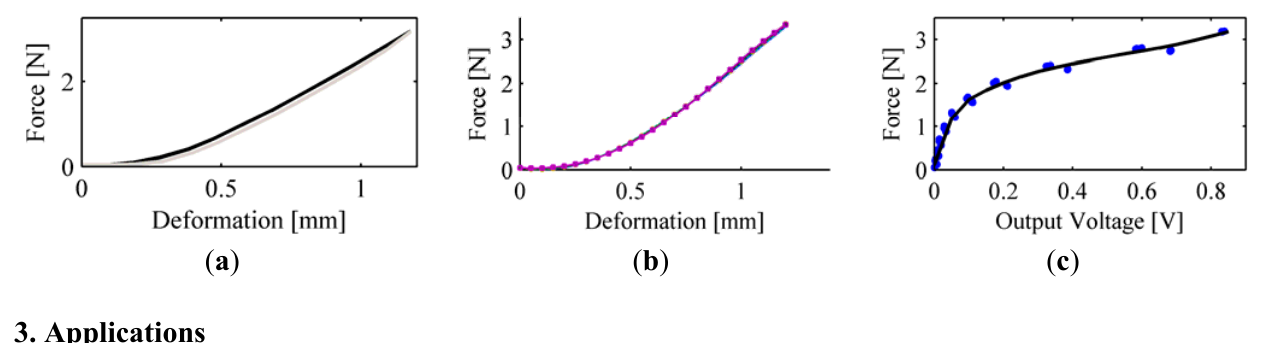
Figure 9. Results of the PSP2.1 characterization: ( a ) quasi-static force-to-deformation loading-unloading, averaged over three iterations (black line is the loading phase, grey line is the unloading phase); ( b ) all fitting curves of loading-unloading cycles at seven different levels of loading speed (namely, 0.05, 0.1, 0.2, 0.3, 0.4, 0.5, 1 mm/s); ( c ) quasi-static force-to-voltage curve (blue dots are experimental data, black line is the smoothing